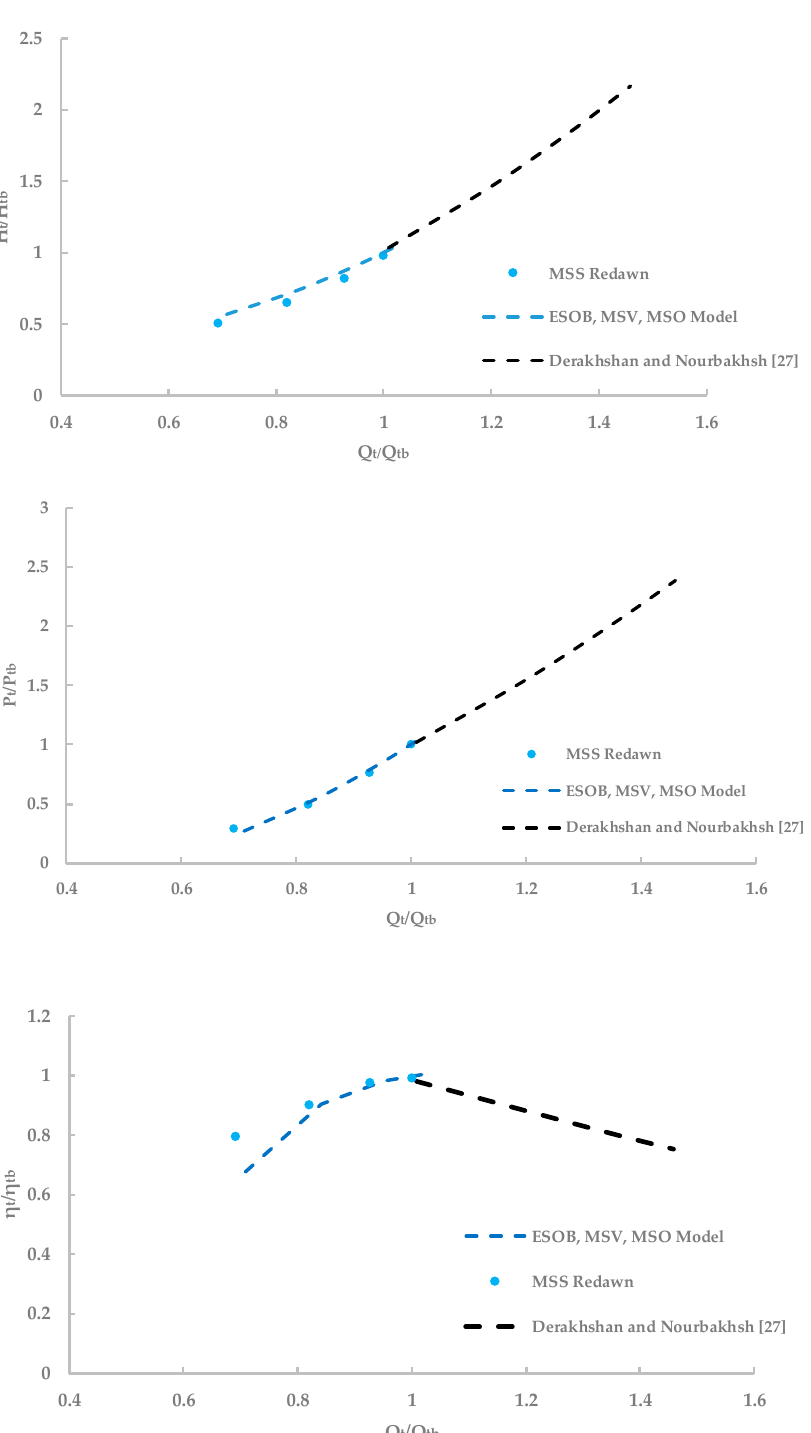
Figure 10. Characteristic curves for the ’P(E18S64) / 1A’ MSS pump. Experimental data (dots), proposed model (blue dashed line), and Derakhshan and Nourbakhsh [27] model (black dashed line): head-discharge ( upper panel), power-discharge ( central panel), and efficiency-discharge ( lower panel).